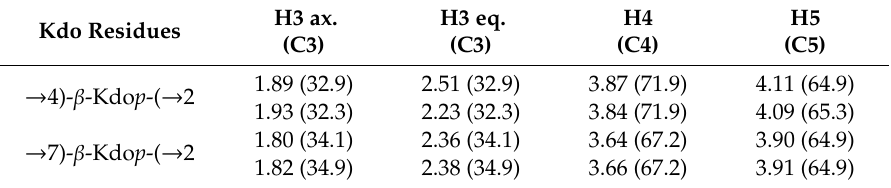
Table 2. Chemical shifts (ppm) of the Kdo residues from Escherichia coli K5 CPS. Kdo